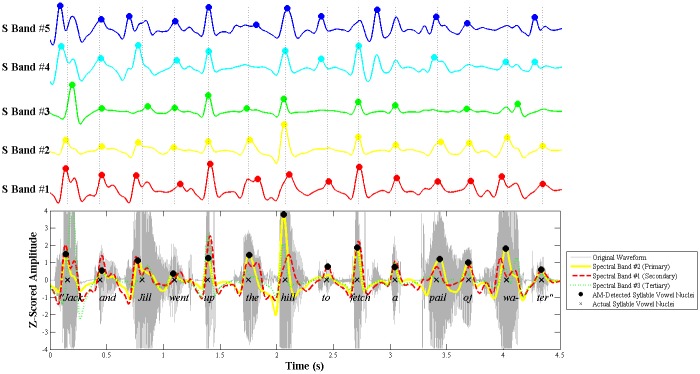
Example of Syllable AM peak detection and evaluation.The example shows the trochaic nursery rhyme sentence "Jack and Jill". (Top). The Syllable AMs from spectral bands 1–5 are each plotted in separate rows in different colours. The original pool of candidate peaks that were detected in these 5 AMs are shown as coloured dots. The vertical dotted lines indicate the actual (manually-annotated) location of syllable vowel nuclei in the sentence.(Bottom) Results of the peak evaluation procedure. The Syllable AMs from 3 power-ranked primary (Band #2), secondary (Band #1) and tertiary (Band #3) spectral bands are overlaid on the original acoustic waveform. The final selected Syllable AM peaks (= model-detected syllable vowel nuclei) are shown as black dots. The actual syllable vowel nuclei in the utterance are shown as black crosses. Notice that the Syllable AM peaks in the primary spectral band (#2, yellow) correctly correspond to almost all the actual syllable vowel nuclei, with the exception of the syllable "to", whose vowel nucleus is captured within the secondary spectral band (#1, red).